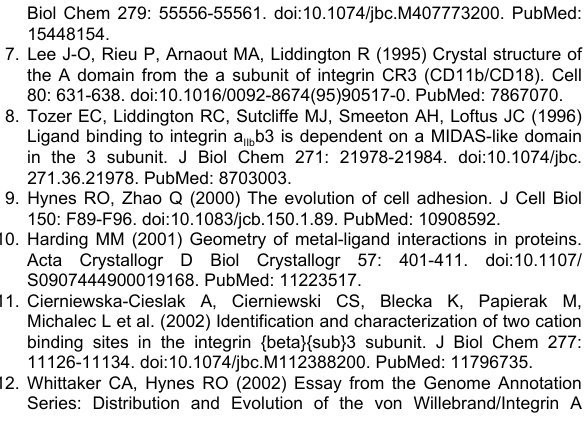
Figure S5. Key distances of the ions in the simulations with initially placed in Mg2+-Ca2+-Ca2+ state in wild-type